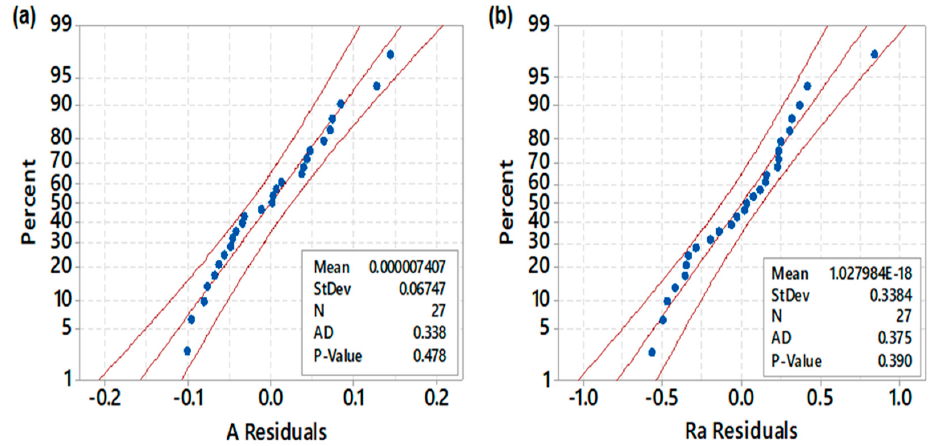
Figure 5. Normal probability plots of residuals for: ( a ) mean kerf angle, ( b ) mean surface roughness.